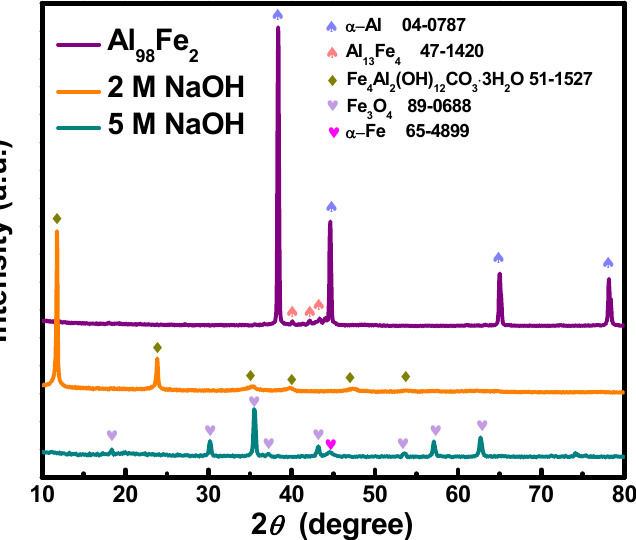
Figure 2. Typical XRD patterns of Al 98 Fe 2 precursor ribbons and the two as-dealloyed samples.